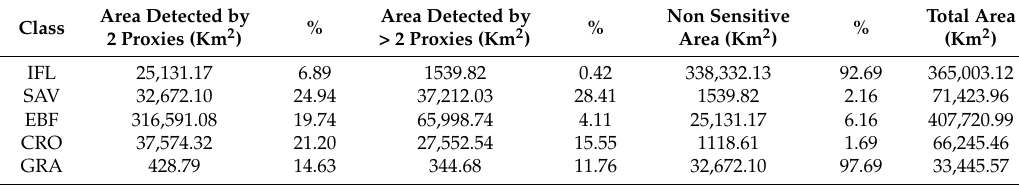
Figure 7. Sensitive regions detected by more than two datasets in ENSO and rainfall and associated vegetation cover categories such as savanna and cropland in Java ( A ) and East Nusa Tenggara ( B ), and evergreen broadleaf forest in Kalimantan ( C ). Table 3. Associated vegetation cover types with the frequent sensitive areas in ENSO and rainfall.